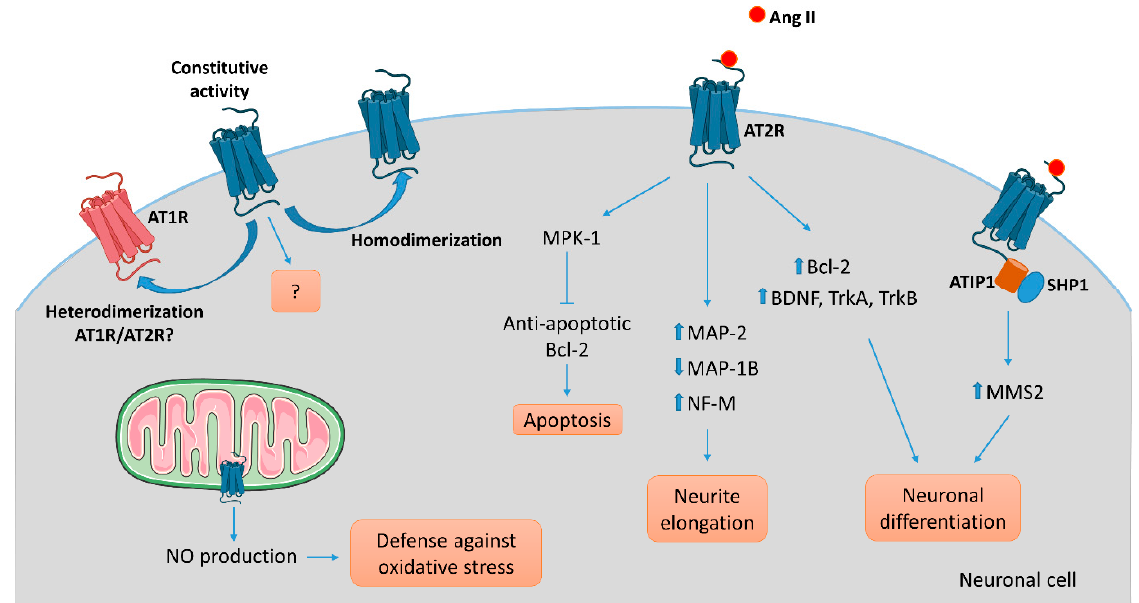
Figure 3. AT2R-mediated intracellular signaling pathways involved in neuronal cells. Several intracellular signaling pathways are associated with AT2R activation in neuronal cells leading to apoptosis via activation of the phosphatase MPK-1, neurite elongation via reorganization of the cytoskeleton, or neuronal differentiation in part via upregulation of growth-factors, depending on the cell type, the context, and the environment. To date, ATIP1 is identified as a partner of AT2R involved in intracellular signaling pathway and trafficking in neuronal cells. While the evidence of an ATIP/AT2R complex comes from experiments on central nervous system neurons, we could hypothesize that a similar system exists in PNS neurons. AT2R signaling may antagonize AT1R-mediated signaling by a direct heterodimerization between the two. As well, homodimerization of AT2R might result in ligand-independent signaling.